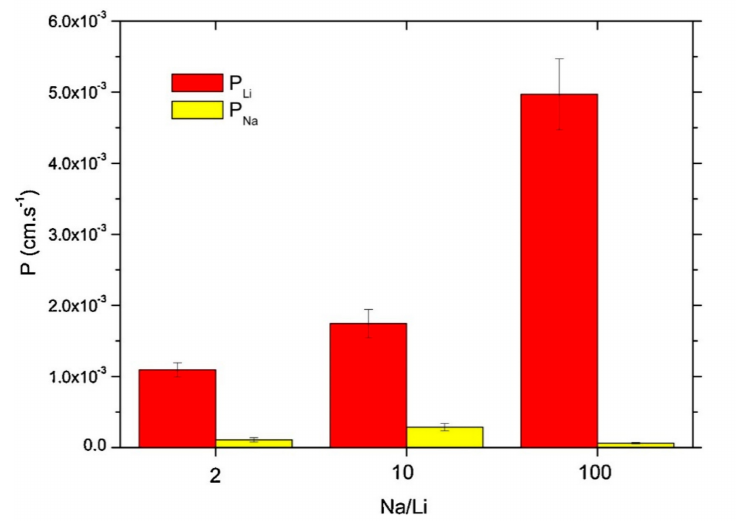
Figure 5. Lithium permeability (P Li ) and sodium permeability (P Na ) versus initial sodium / lithium molar ratio in the aqueous feed phase. Feed phase: LiCl (1 mmol L − 1 ), NaCl (variable), pH = 12